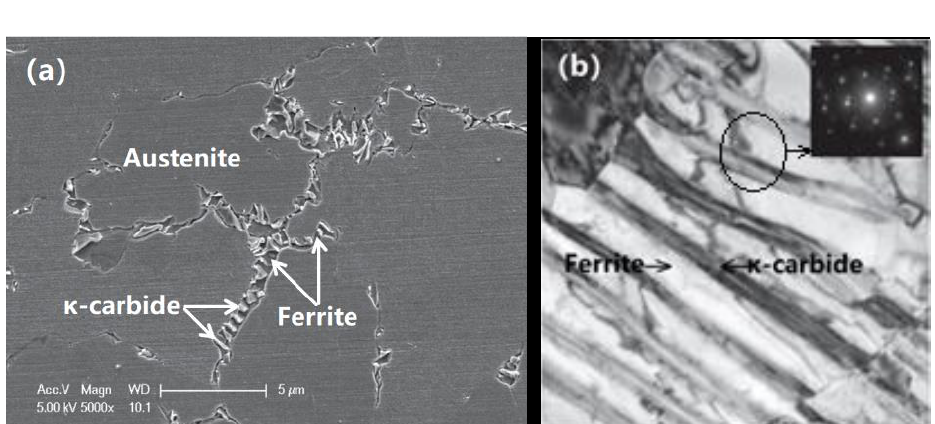
Figure 7. Engineering stress-strain curves of Fe – 28Mn – 10Al – C – 0.5Nb low-density steel tested at room temperature at an initial strain rate of 1 × 10 − 3 s − 1.